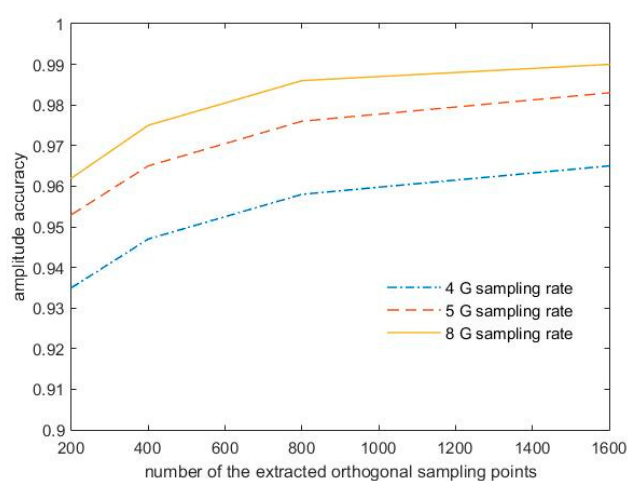
Figure 7. The measured amplitude accuracy with different number of orthogonal sampling points at different sampling rates.